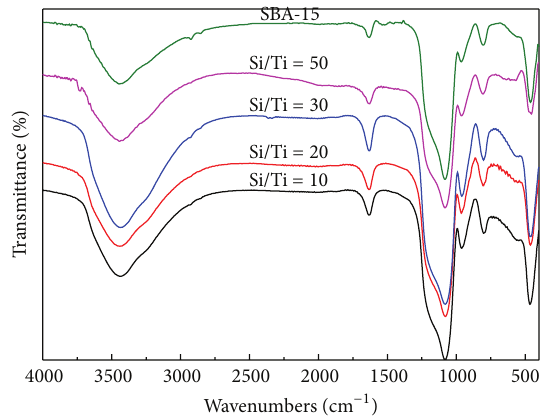
Figure 3: FT-IR spectra of different Ti-containing